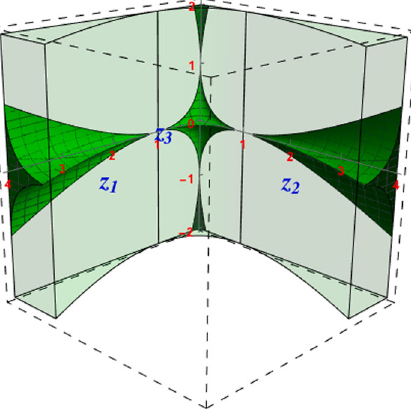
Fig. 6 Extended convergence region where a careful numerical treat- ment is needed (light green)